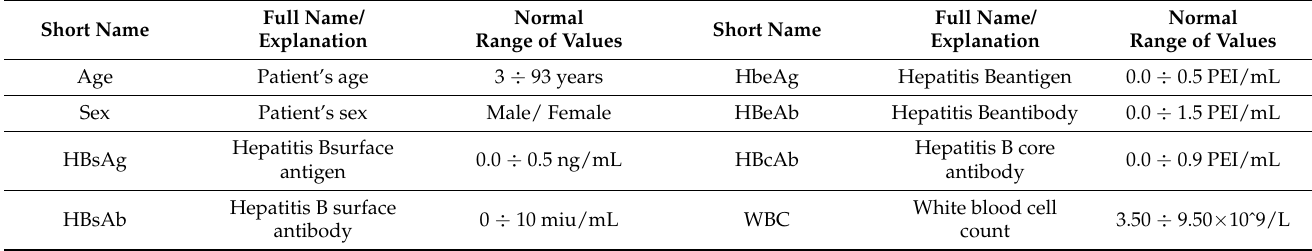
Table 3. Human body’s health indicators with their normal ranges of